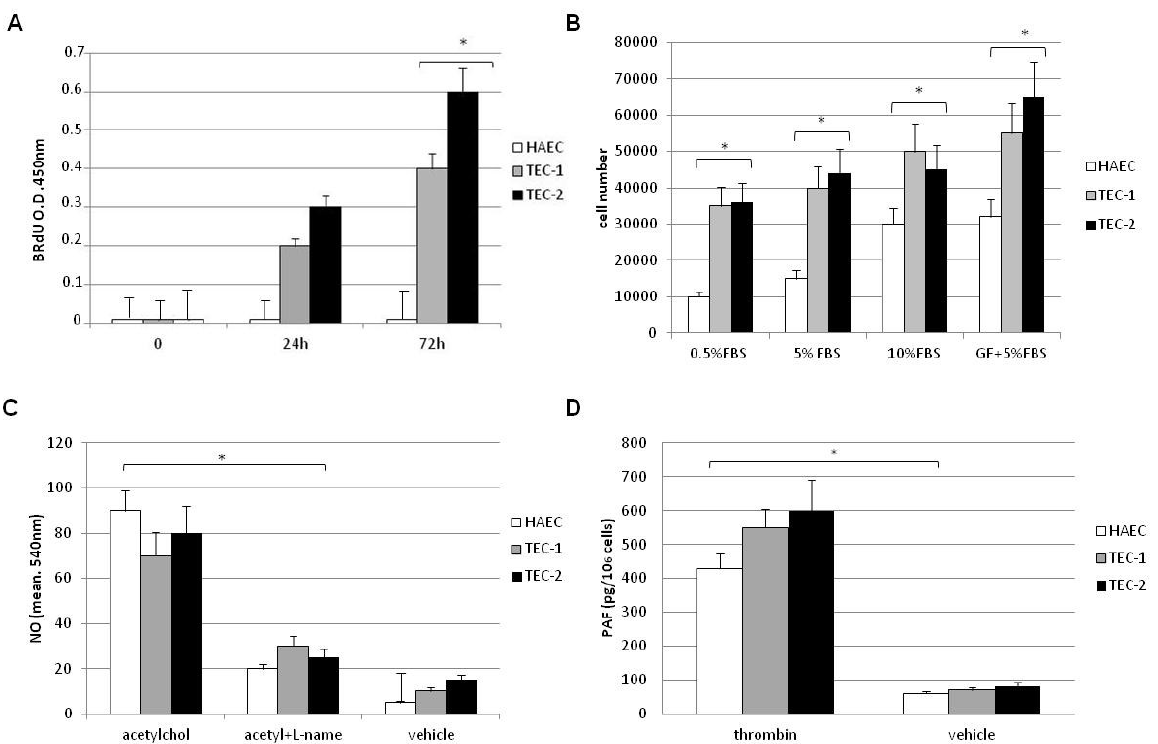
Figure 4. Growth and functional characterization of TECs. ( A ) BrdU incorporation by TEC 1 (grey column), TEC 2 (black column) and HAECs (white column) cultured in EGM-2 in presence of 0.5% serum. ( B ) Proliferation of normal HAECs (white columns), TEC 1 (grey columns), and TEC 2 (black columns) in response to different concentrations of FCS or to FCS plus growth factors (GFs) added to medium for cell culture, evaluated after 72 h. Results are the mean ± SE of at least six experiments, p < 0.001 vs . HAECs. ( C ) Nitric oxide assay. Cells were incubated with vehicle alone, 1 μM acetylcholine, or 1 μM acetylcholine in the presence of 10 −3 M of L-NAME. Activity of the endogenous NO system was controlled by stimulating cells with L -arginine, the substrate for NO synthase (data not shown). Experiments were repeated three times. NO values are expressed as cell absorbance at 540 nm, mean ± SE p < 0.001 vs . control. ( D ) PAF production from 1 × 10 6 normal HAECs (white columns), TEC 1 (grey columns), and TEC 2 (black columns) incubated with vehicle or with 2 U/mL thrombin for 15 min at 37 °C. Data are the mean ± SE of three individual experiments; p < 0.001 vs . control